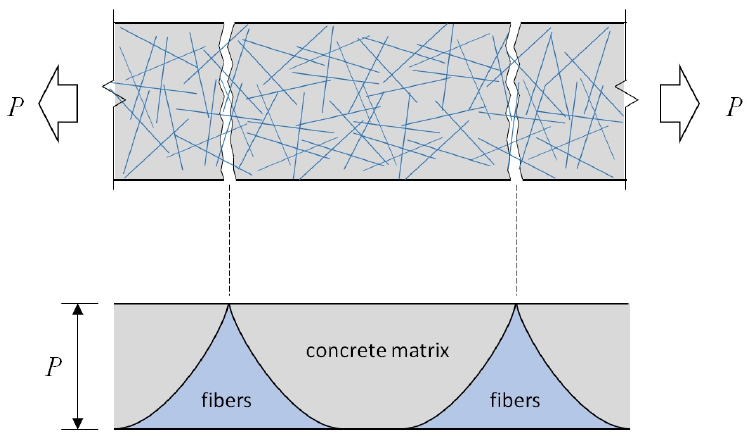
Figure 5. Concrete matrix and steel fiber tensile stress distributions between cracks.